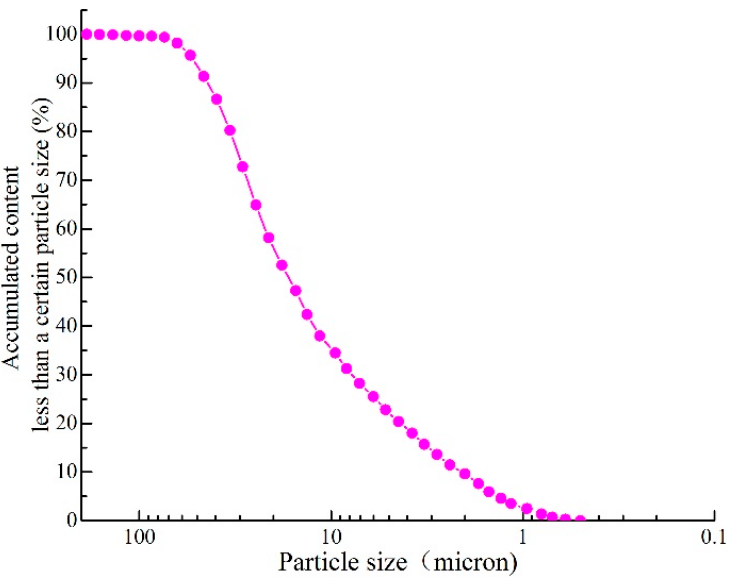
Figure 2. Gradation curve of the cement.